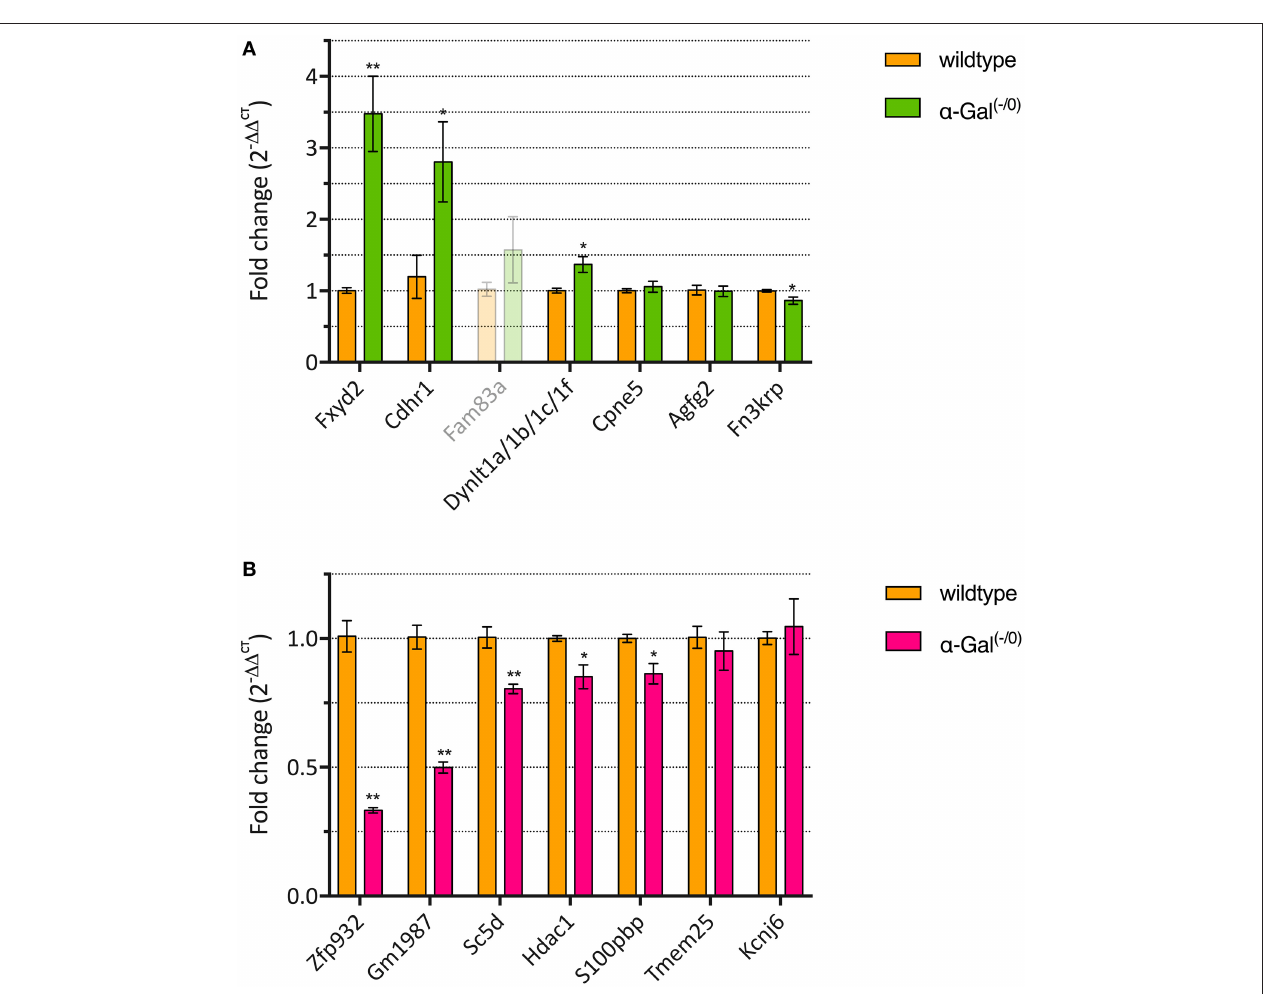
FIGURE 3 | RT-qPCR validation of up- (A) and downregulated genes (B) . * p < 0.05, ** p < 0.01.